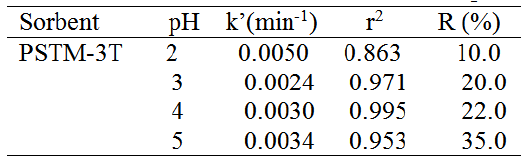
Table 4. The first-order reaction rate constants for PSTM-3T at different pHs a